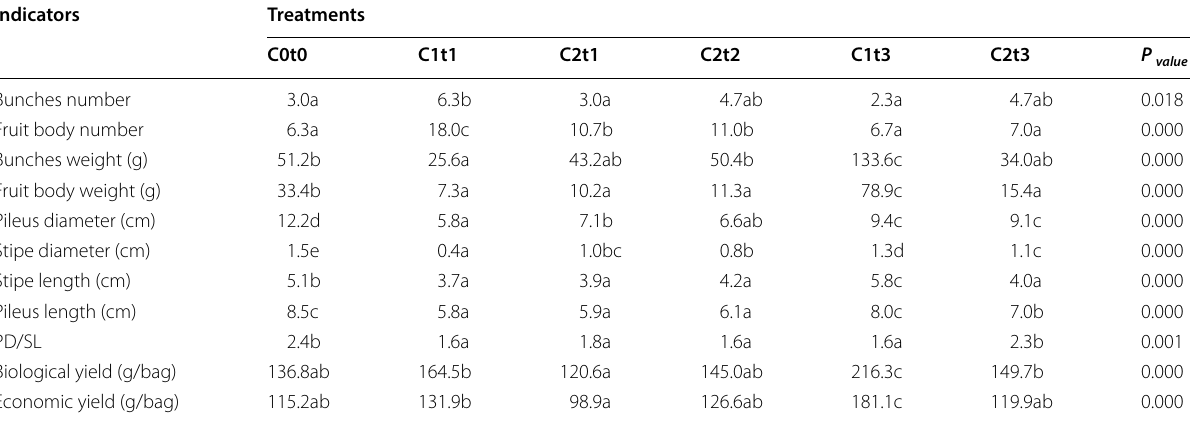
Values are means; means within the same row followed by the same letters are not significantly different at P < 0.05 according to Duncan’s multiple range test, ns: non-significant effect